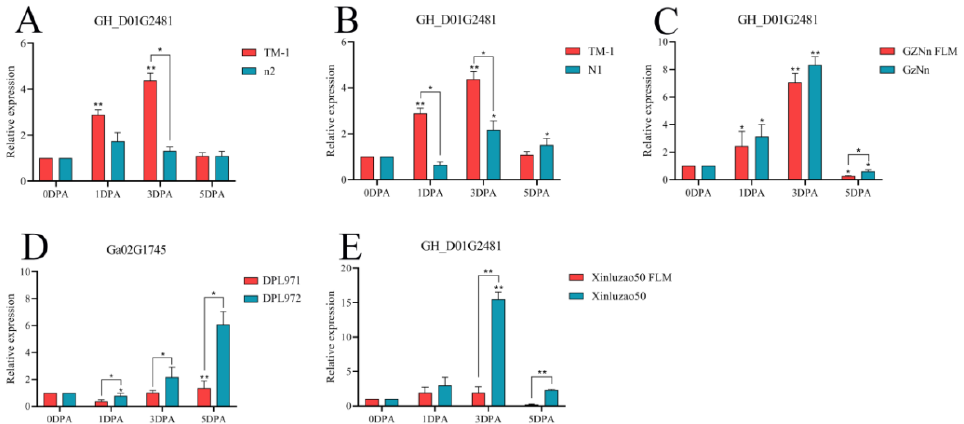
Figure 15. Relative expression levels of the GH_D01G2481 gene in upland cotton. ( A – C , E ) Upland cotton; ( D ) homologous gene of Asian cotton. Asterisks at top of bars indicate statistically significant differences between periods (* p < 0.05, ** p < 0.01).